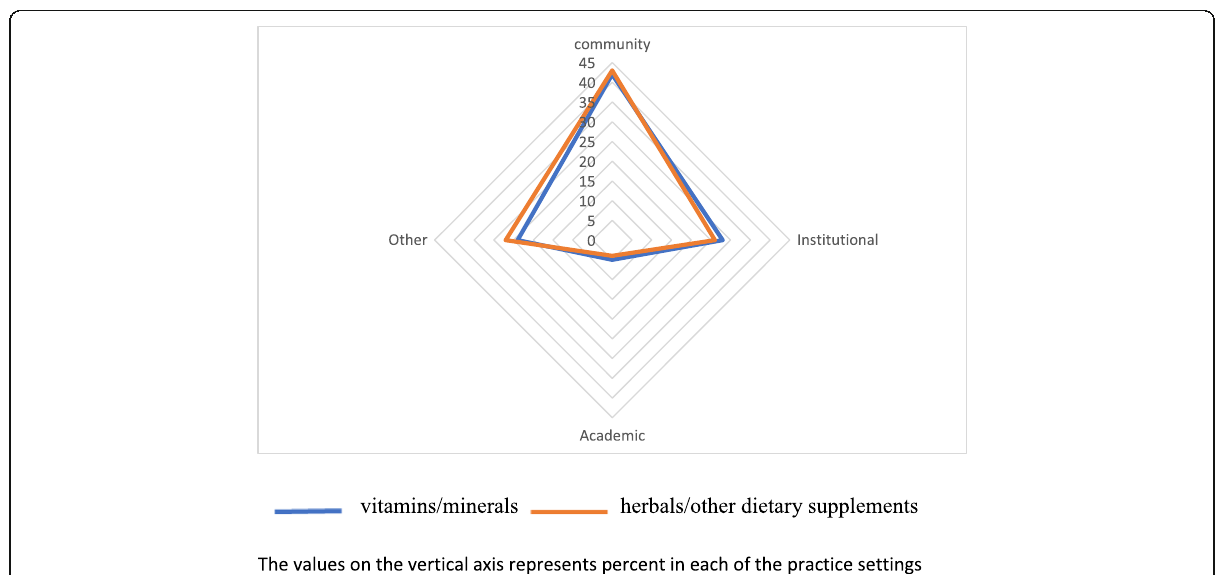
Fig. 2 Radar chart indicating vitamin/mineral and herbals/other dietary supplements use by practice